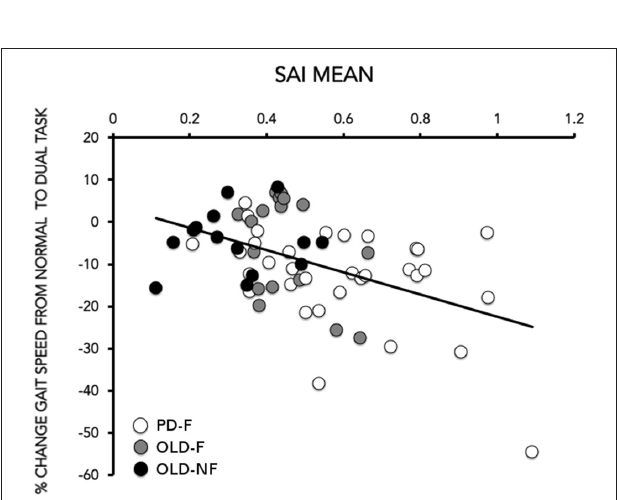
FIGURE 3 | Correlation between the grand mean of SAI ( X -axis) and the % change in gait speed (gait speed) from normal to dual task ( Y -axis) . The % change in gait speed was calculated as (gait speed dual task − gait speed single task )/gait speed single task ) × 100. Data of PD (white circles), older adults fallers (OLD-F: gray circles) and older adults non-fallers (OLD-NF: black circles) are plotted